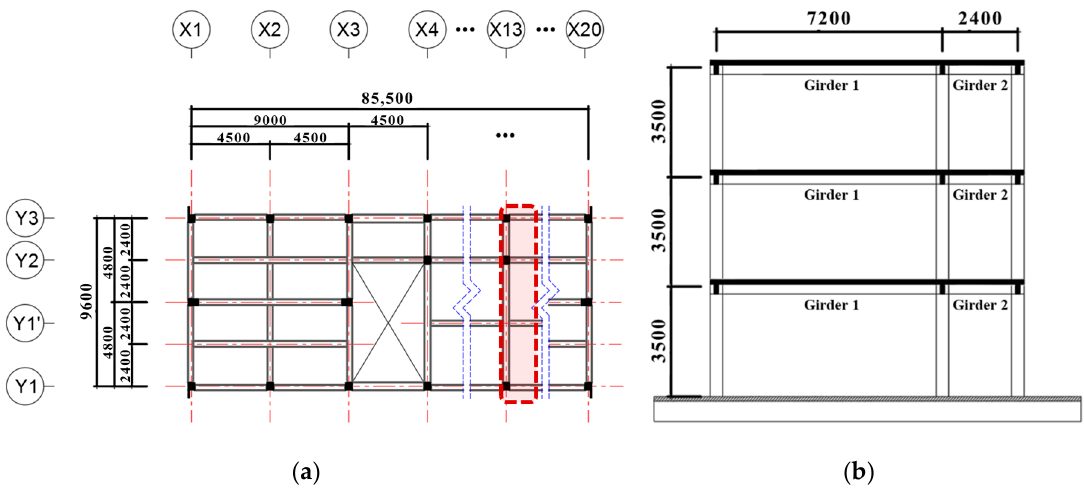
Figure 2. Plan view and elevation of the selected reinforced concrete (RC) structure (unit: mm): ( a ) plan; ( b ) elevation.